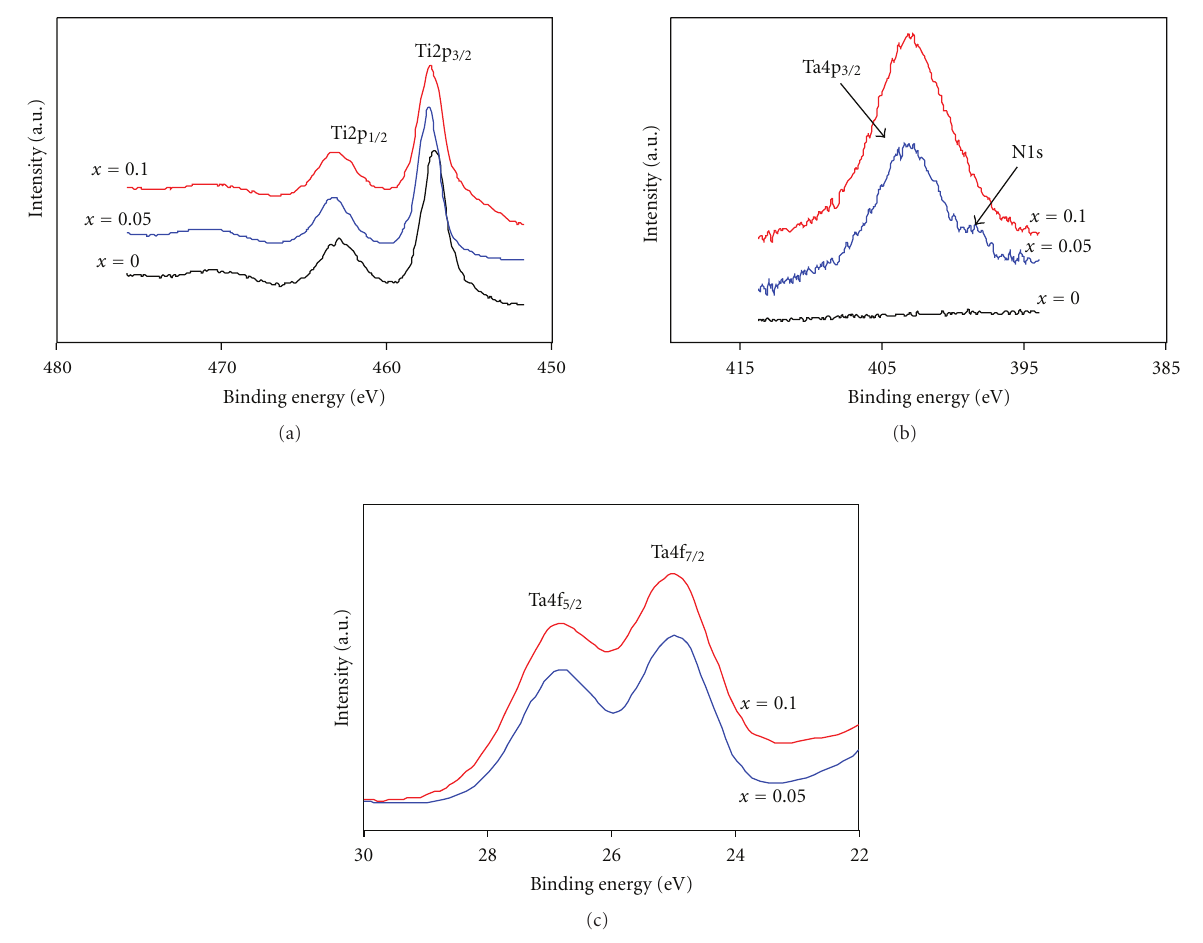
Figure 8: X-ray photoemission spectra of SrTi 1 − x Ta x O 3 − y N y ( x = 0,0 . 05,0 . 1), Ti2p (a), Ta4p (b), and Ta4f (c).